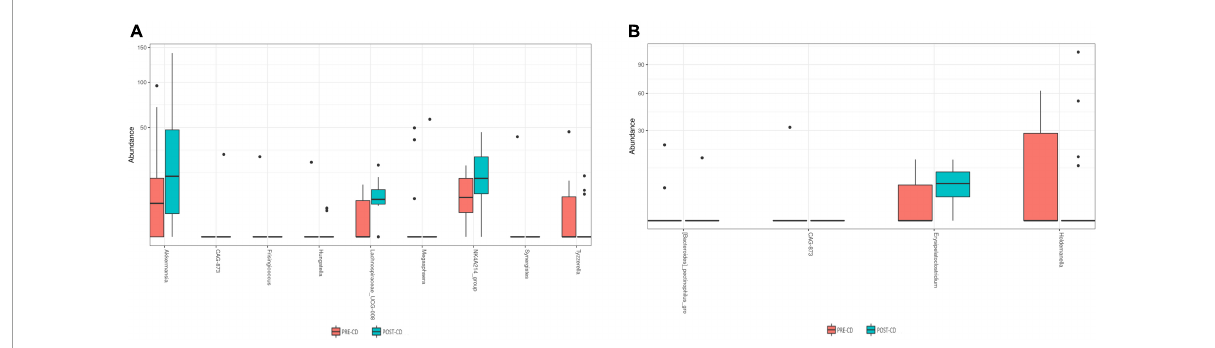
FIGURE4 Box plots showing significant differentially abundant genera among pre- and post-AD (A) and pre- and post-CD (B) samples. AD, ancient-wheat diet; CD, control-wheat diet.